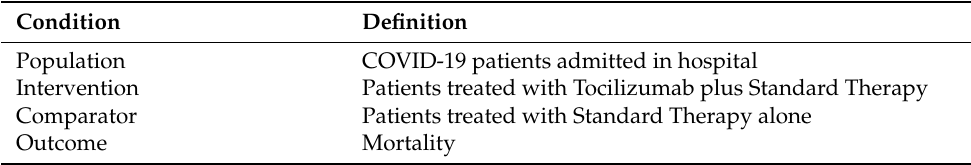
Table 1. PICO format used to focus the research